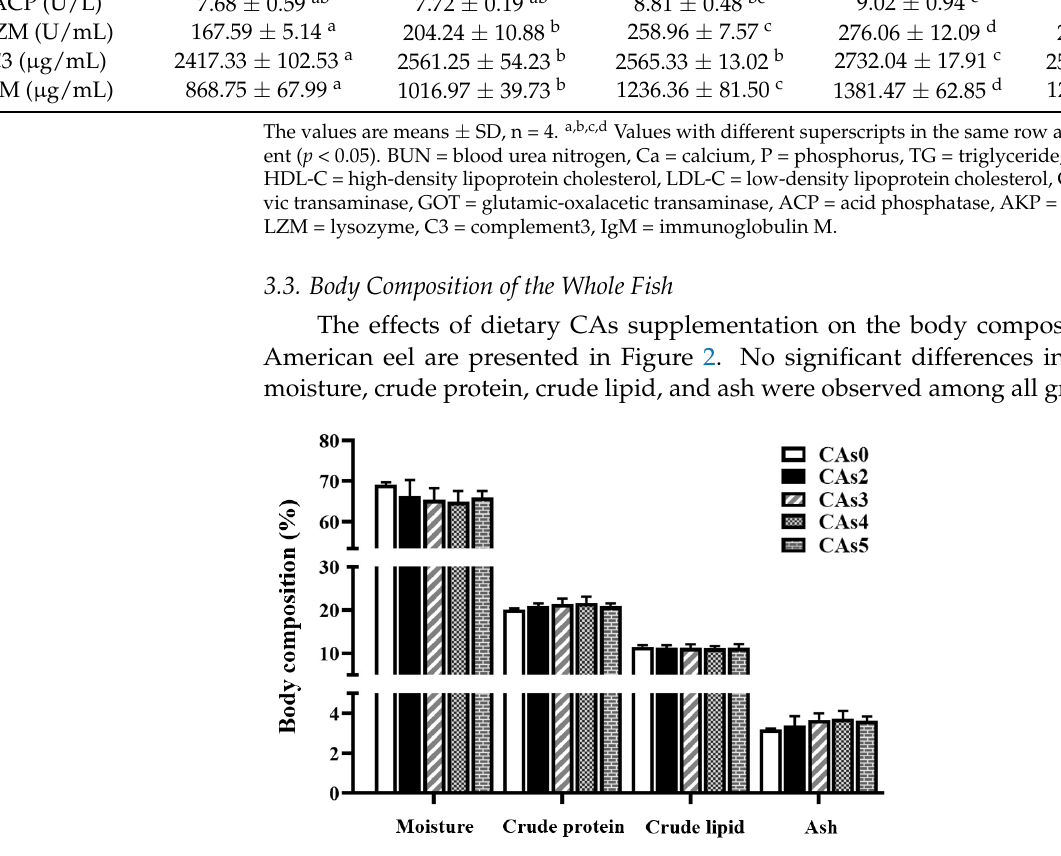
Figure 2. Body composition of juvenile American eel in different CAs supplementation groups. No superscript on the bar chart means no significant difference ( p > 0.05).